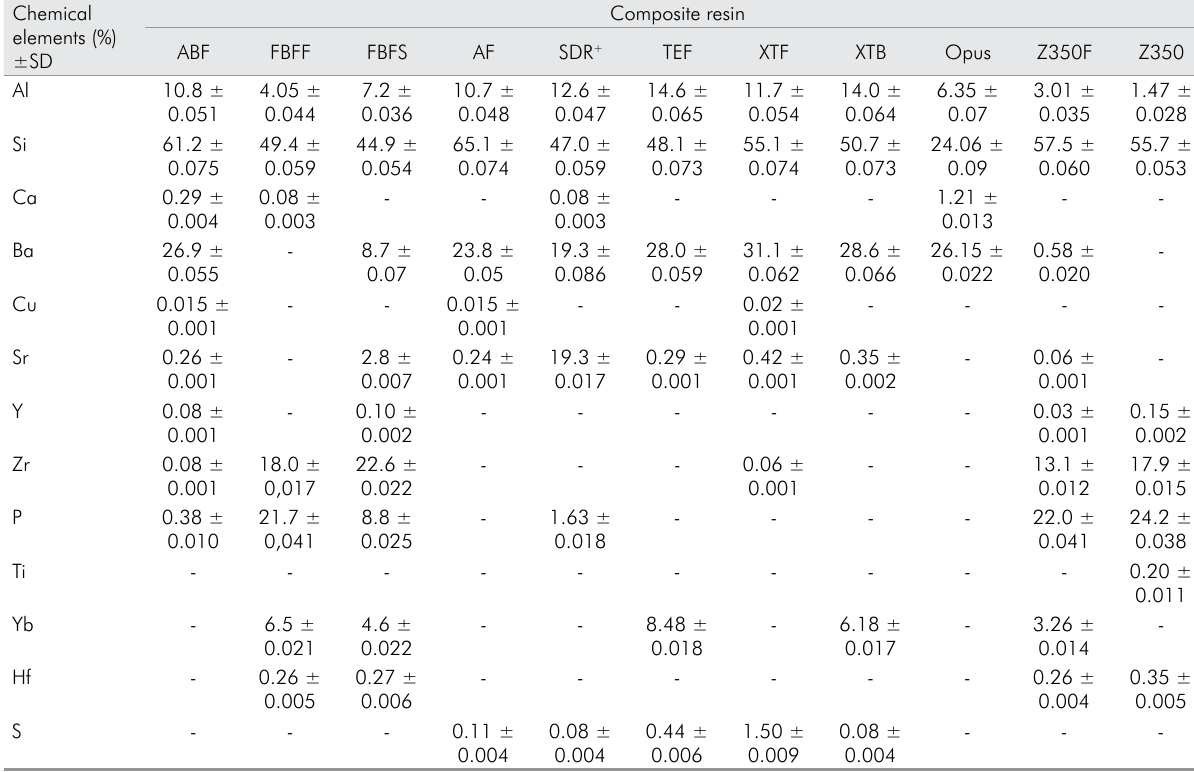
Table 7. Chemical elements identified by means of EDS analysis (% and SD). Chemical elements